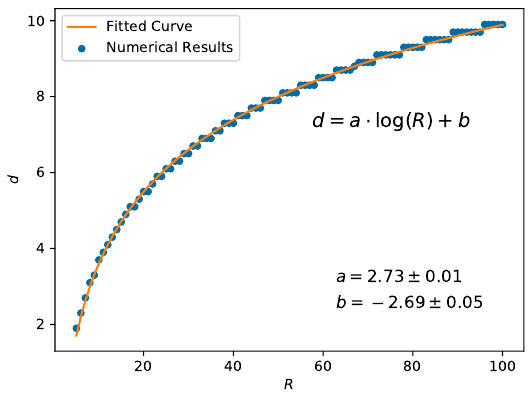
Figure 13. Logarithmic growth of string separation d as a function of R , with fitted parameters (for SU(5) , k = 2 ). The step-like nature of the data is entirely a numerical side-effect: the pixels of the discretization have size h = 0 . 1 , while R is increased in intervals of 1 . When log( R ) grows slower than 0 . 1 upon an increase of ∆ R = 1 , the width will have a step-like growth.